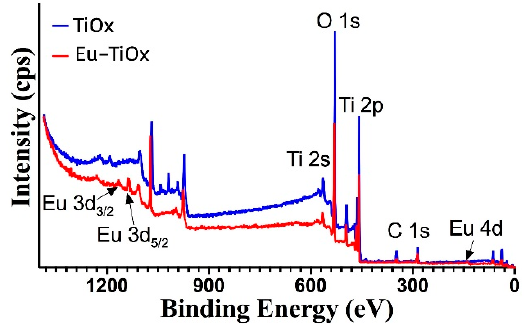
Figure 3. XPS surface analysis of undoped and Eu-doped TiOx thin films.